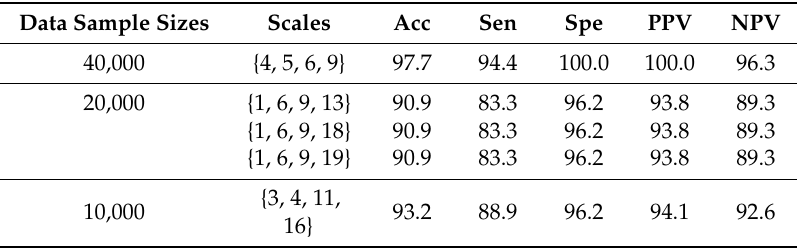
Table 2. List of the combinations of the optimal four MSE ( r = 0.20) scales for discrimination between young NSR and CHF participants using LDA, as well as their corresponding accuracy,